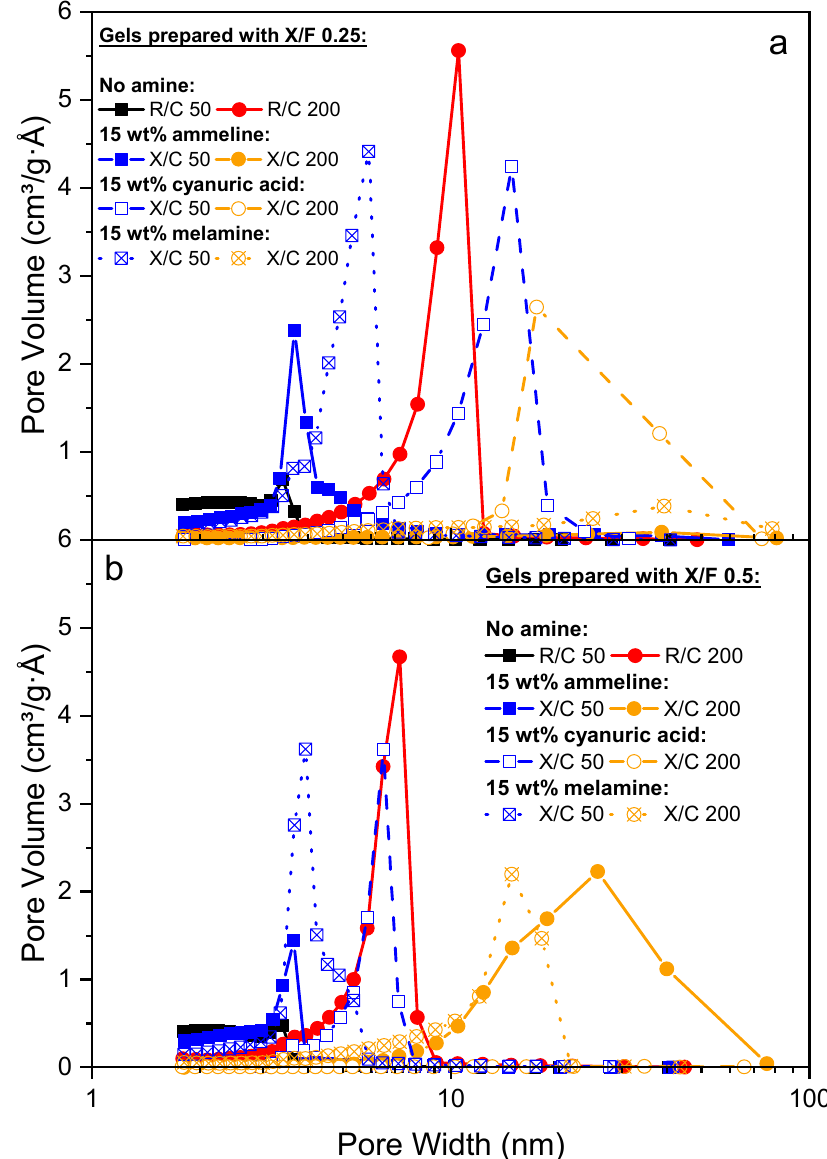
Figure 2. Pore size distributions for gels prepared with 15 wt% of additives with ( a ) X/F 0.25 and ( b ) X/F